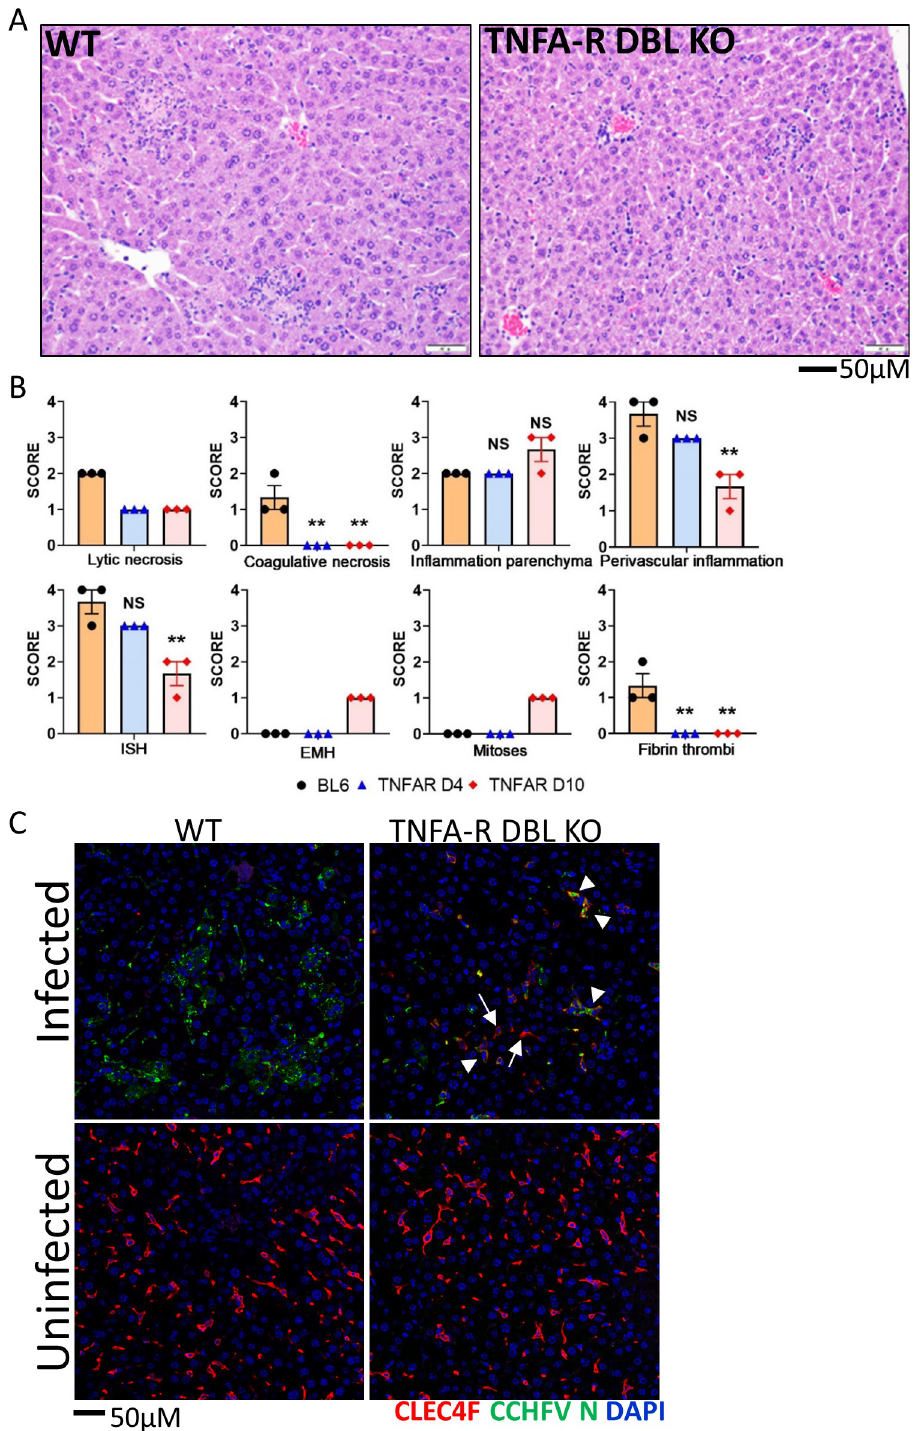
Fig 5. Liver injury is reduced in CCHFV infected mice missing TNFA-R signaling. A Representative H&E staining of livers from WT (C57BL/6) and TNFA-R DBL KO mice infected with CCHFV in the presence or absence of IFN-I blockade harvested on Day 4. Livers have multifocal areas of random, lytic and single cell hepatocyte necrosis with accompanying inflammation which are larger in WT mice compared to the smaller, more discrete areas of necrosis in TNFA-R DBL KO mice. B. Pathology scores were plotted for the indicated lesions or ISH staining (n = 3/group/time point). Statistical significance of day 4 and day 10 infected, TNFA-R DBL KO mice compared to infected controls was